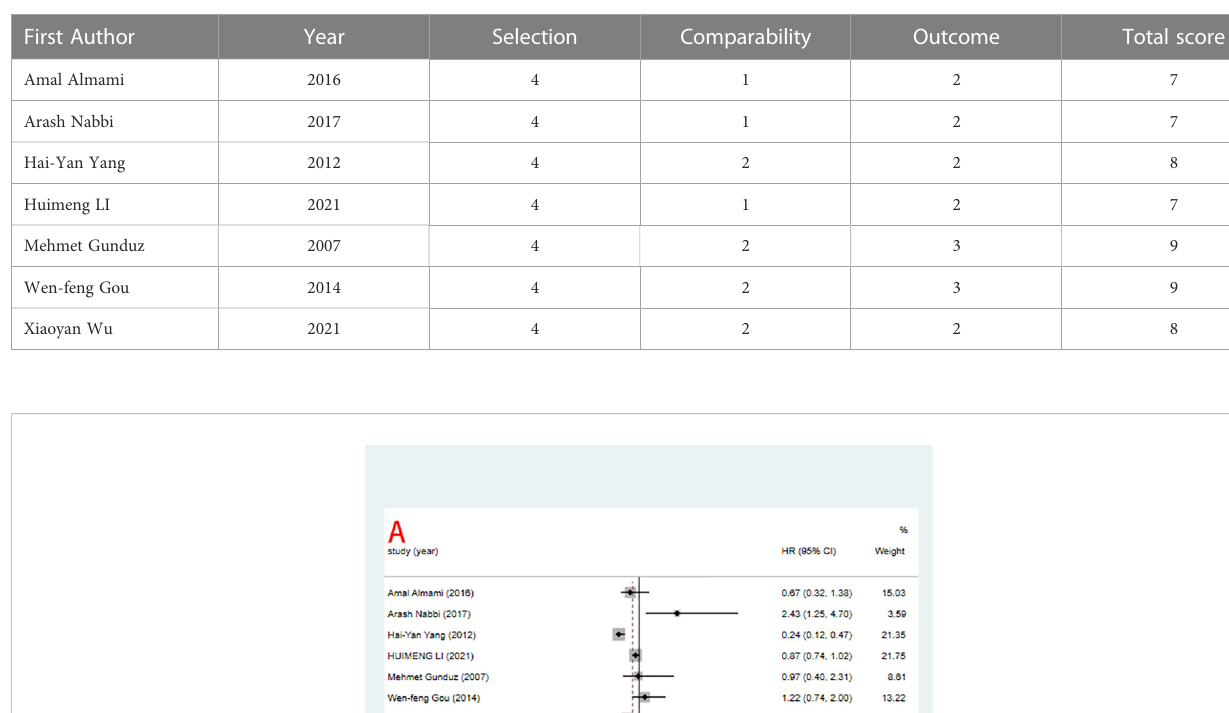
TABLE 2 NOS score of the included studies.